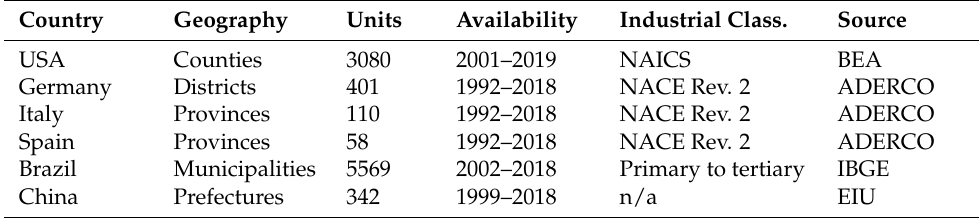
Table 1. Sources of subnational GDP